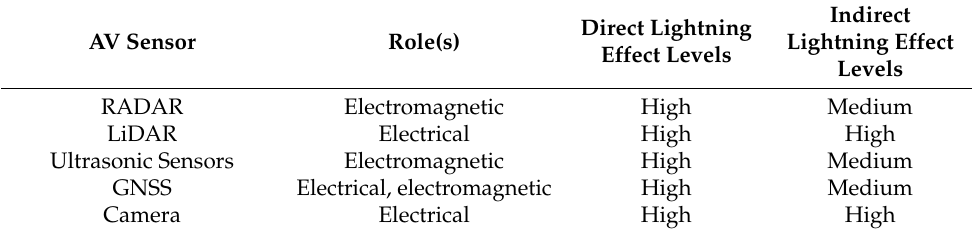
Table 3. Effects of direct and indirect lightning on AV